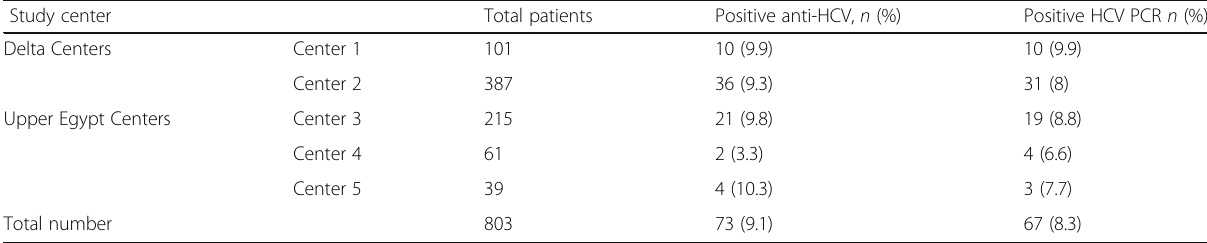
Table 3 Distribution of seropositive HCV and positive PCR patients among the study centers Study center